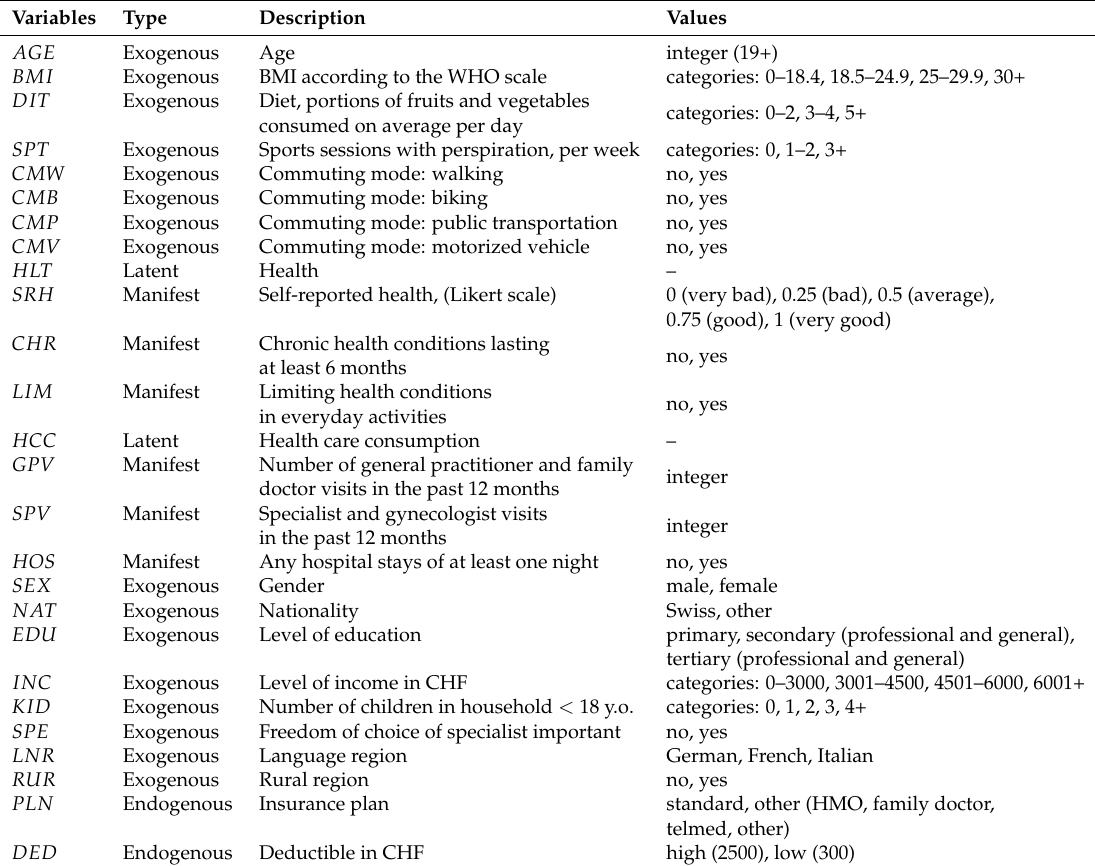
Figure 1. Illustration of the path diagram of the structural equation model. Table 1. Description of the variables used in the